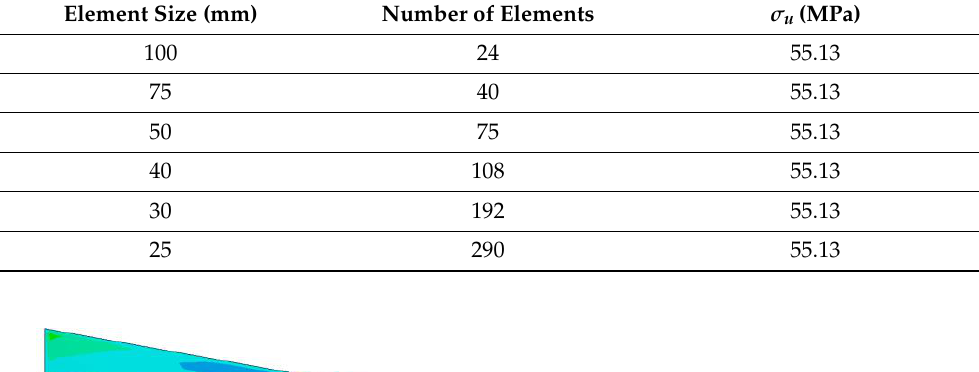
Table 3. Mesh convergence test for the verification of the computational model by Shanmugam and Narayanan [25].